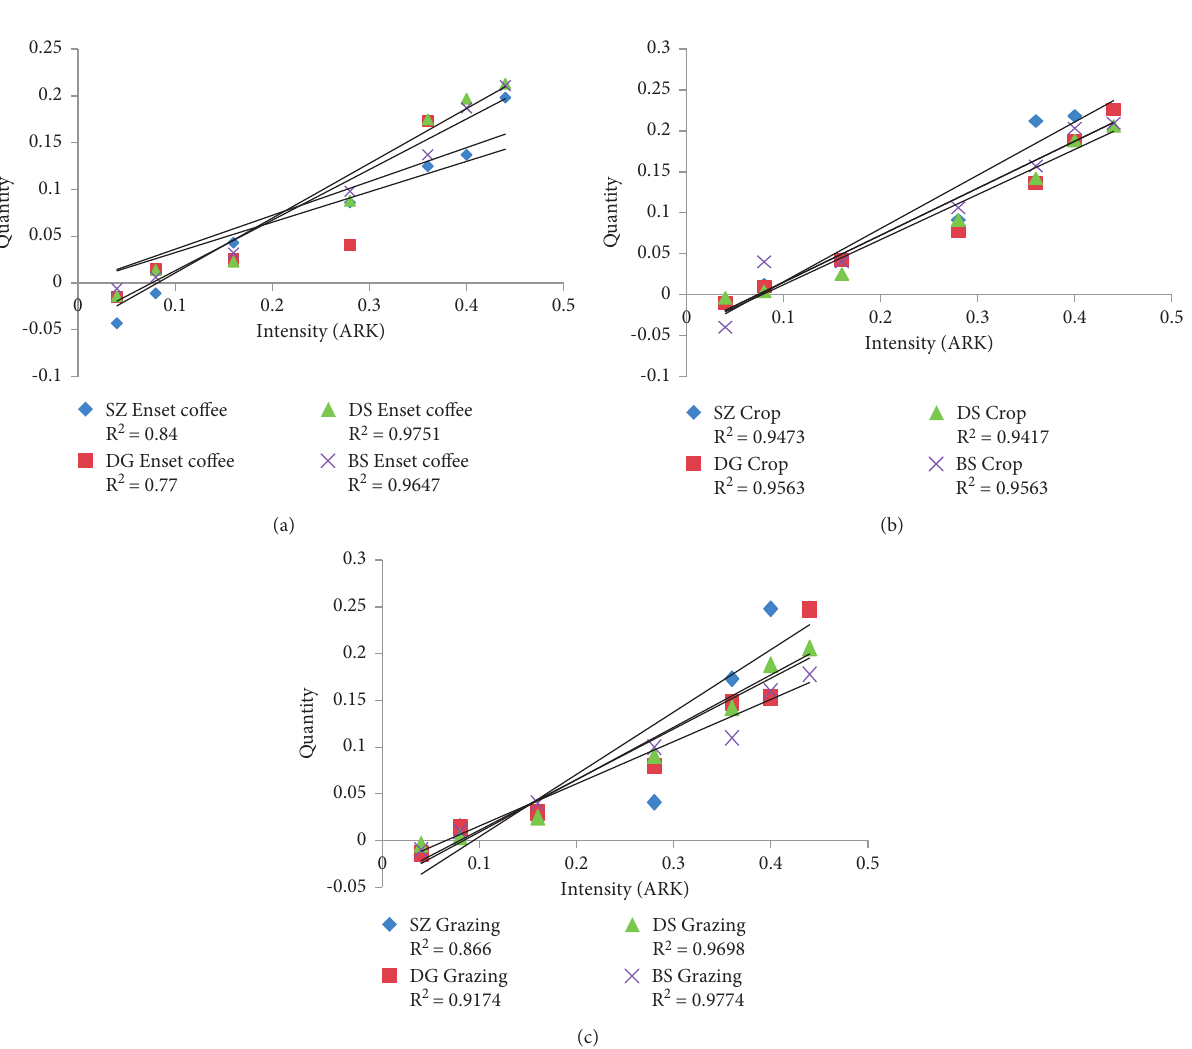
Figure 3: (a). The quantity-intensity isotherms of enset-coffee complex soils. (b) The quantity-intensity isotherms of crop land soils. (c) The quantity-intensity isotherms of grazing land